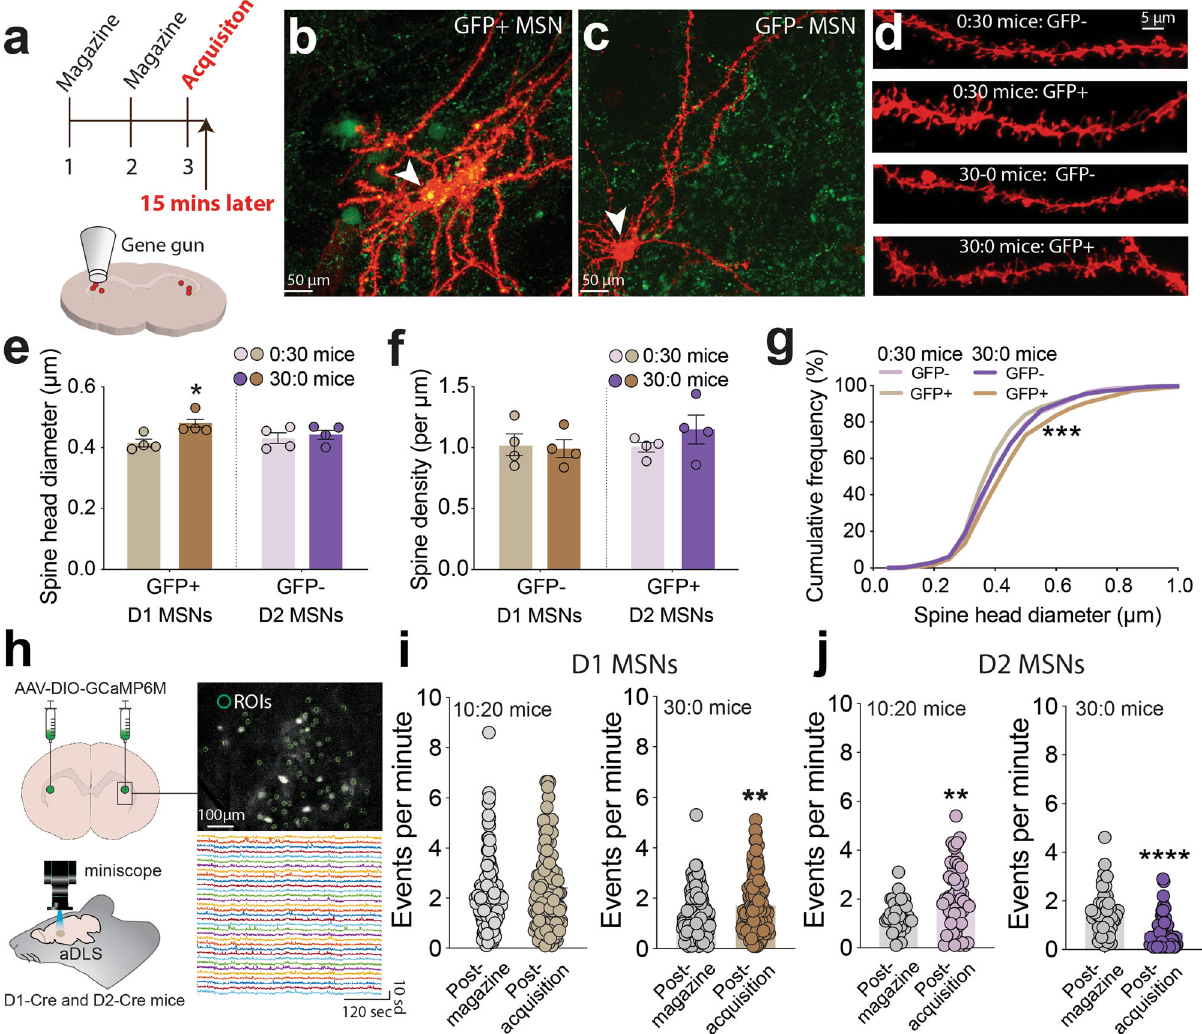
Fig. 4 Opposite modulation of D1 and D2 MSN activity in aDLS during consolidation. a Graphical representation of experimental design (upper) and the DiOlistic labeling of MSNs using Dil-coated tungsten particles (lower). b Representative image of a DiI- fi lled MSN (red) that expressed GFP (green; GFP + ) in aDLS from D1-Cre mice injected with AAV-DIO-GFP (note yellow-colored cell body; presumptive D1 MSN). c Representative image of a DiI- fi lled MSN (red) that did not express GFP (GFP-; presumptive D2 MSN). d High-resolution confocal images of dendrites from DiI-labeled GFP + and GFP- MSNs from the aDLS of 30:0 and 0:30 mice. e Mean (±s.e.m.) spine head diameter in presumptive D1 and D2-MSNs from 30:0 and 0:30 mice ( n = 4 animals per group; each data point is the mean head diameter of 6 – 12 neurons from each animal); F (1, 12) = 6.804, p = 0.0229, main effect of Training in Two-way ANOVA; * P = 0.0174, post-hoc test. f Mean (±s.e.m.) spine head density in presumptive D1 and D2-MSNs from 30:0 and 0:30 mice ( n = 4 animals per group; each data point is the mean head density of 6-12 neurons from each animal); F (1, 12) = 0.4, p = 0.5192, main effect of Training in Two-way ANOVA. g Cumulative frequency (%) of spine head diameters ( μ m) in presumptive D1 and D2-MSNs from 30:0 and 0:30 mice; F (3,2281) = 15.34, p < 0.0001, One- way ANOVA; *** P < 0.0001, GFP + MSNs from 30:0 mice compared with GFP + MSNs from 0:30 mice. h Graphical representation of virus delivery to the aDLS of D1-Cre and D2-Cre mice to express GCaMP6M in a Cre-dependent manner and collection of calcium events using miniscopes (left panels). Also represented is the identi fi cation and processing of regions of interest (ROIs) from calcium imaging data, and representative calcium traces from ROIs collected during the post-learning consolidation period (right panels). i , Mean (±s.e.m.) number of calcium events per minute identi fi ed in the aDLS of 10:20 and 30:0 D1-Cre mice during the post-magazine training period (126 ROIs from n = 3 10:20 mice and 129 ROIs from n = 3 30:0 mice) and during the post-acquisition period (129 ROIs from n = 3 10:20 mice and 130 ROIs from n = 3 30:0 mice); ** P (t = 2.933, df = 256) = 0.0037 compared with post- magazine period, unpaired two-tailed t-test in 30:0 mice. j Mean (±s.e.m.) number of calcium events per minute identi fi ed in the aDLS of 10:20 and 30:0 D2-Cre mice during the post-magazine training period (40 ROIs from n = 3 10:20 mice and 54 ROIs from n = 3 30:0 mice) and during the post-acquisition period (56 ROIs from n = 3 10:20 mice and 54 ROIs from n = 3 30:0 mice); ** P (t = 3.328, df = 94) = 0.0012 compared with post-magazine period, unpaired two-tailed t test in 10:20 mice; *** P (t = 5.080, df = 106) < 0.001 compared with post-magazine period, unpaired two-tailed t test in 30:0 not 6 h later, dramatically enhanced performance of the new interneurons in the striatum also express dopamine D2 action in the retention test (Fig. 5f). Immediate but not delayed receptors 38 , raising the possibility that post-learning inhibition of cholinergic neurons in aDLS contributed to the increased post-learning inhibition of D2-MSNs in aDLS markedly increased consolidation observed in D2-Cre mice. To explore this the number of response bouts (Fig. 5g), and modestly increased possibility, we injected AAV8-hSyn-DIO-hM4Di-mCherry into bout density (Fig. 5h), during the retention test. Cholinergic